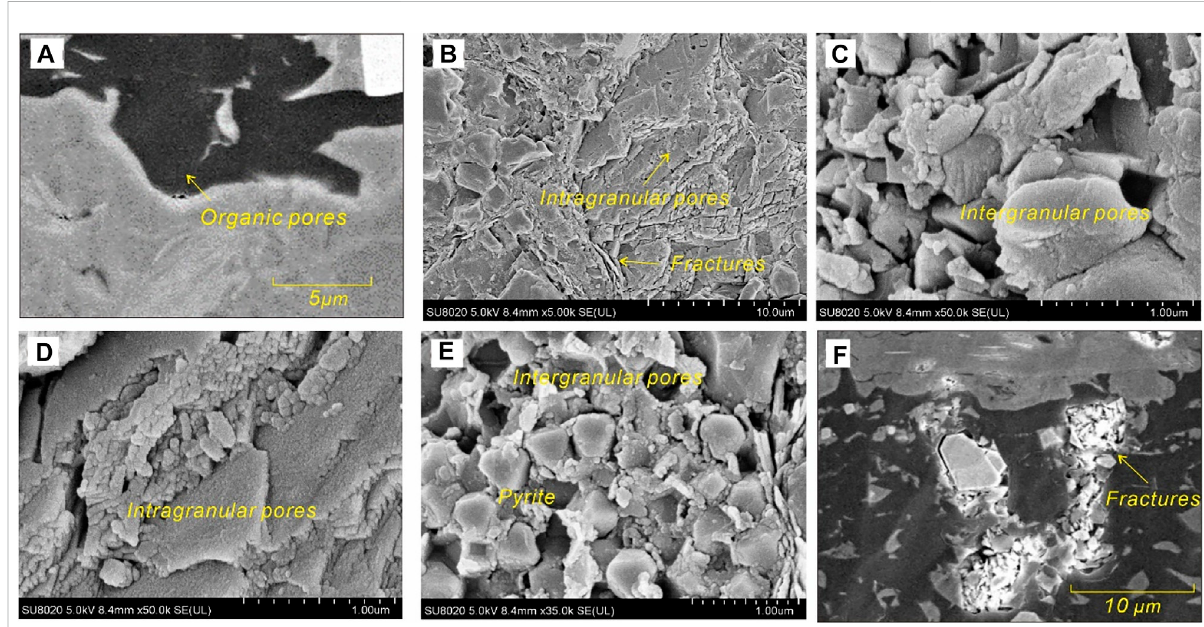
FIGURE 5 Microstructureimagesofcoal-bearingshaleintheeasternOrdosBasin, (A) Organicpores, (B) pore-fracturesystem inshale matrix, (C,D) pores in clay minerals, (E) intergranular pores of pyrite, (F) fractures in shale matrix.